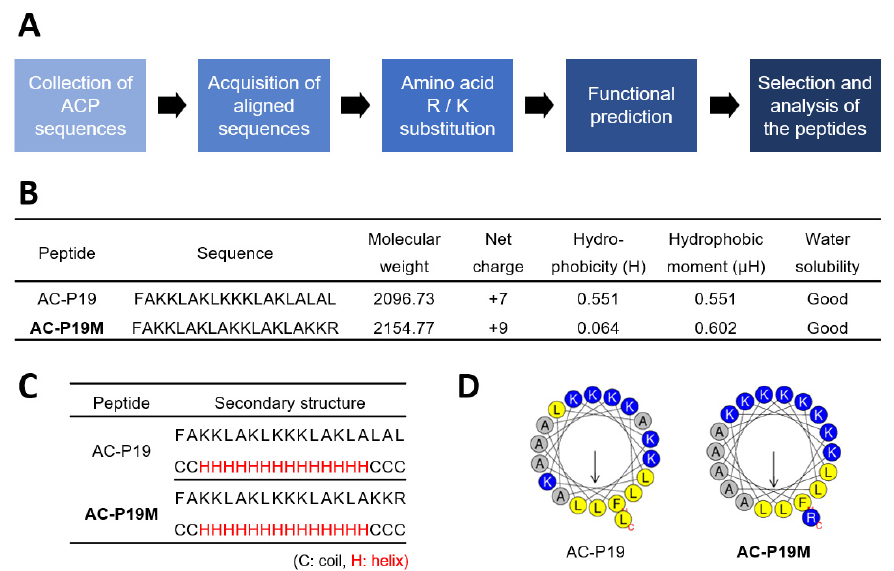
Figure 1. De novo design and characterization of ACPs. ( A ) Scheme of de novo design of novel ACPs. ( B ) Physicochemical properties of AC-P19, aligned sequence from 19-mer ACPs, and AC-P19M, modified sequence of AC-P19 with arginine (R) and lysine (K) substitutions. The peptide sequence, molecular weight, net charge, hydrophobicity, hydrophobic moment, and water solubility of AC-P19 and AC-P19M were calculated. ( C ) The secondary structures of the two peptides were predicted to be helical. ( D ) Amino acid configurations of the helix structures of the peptides are presented.